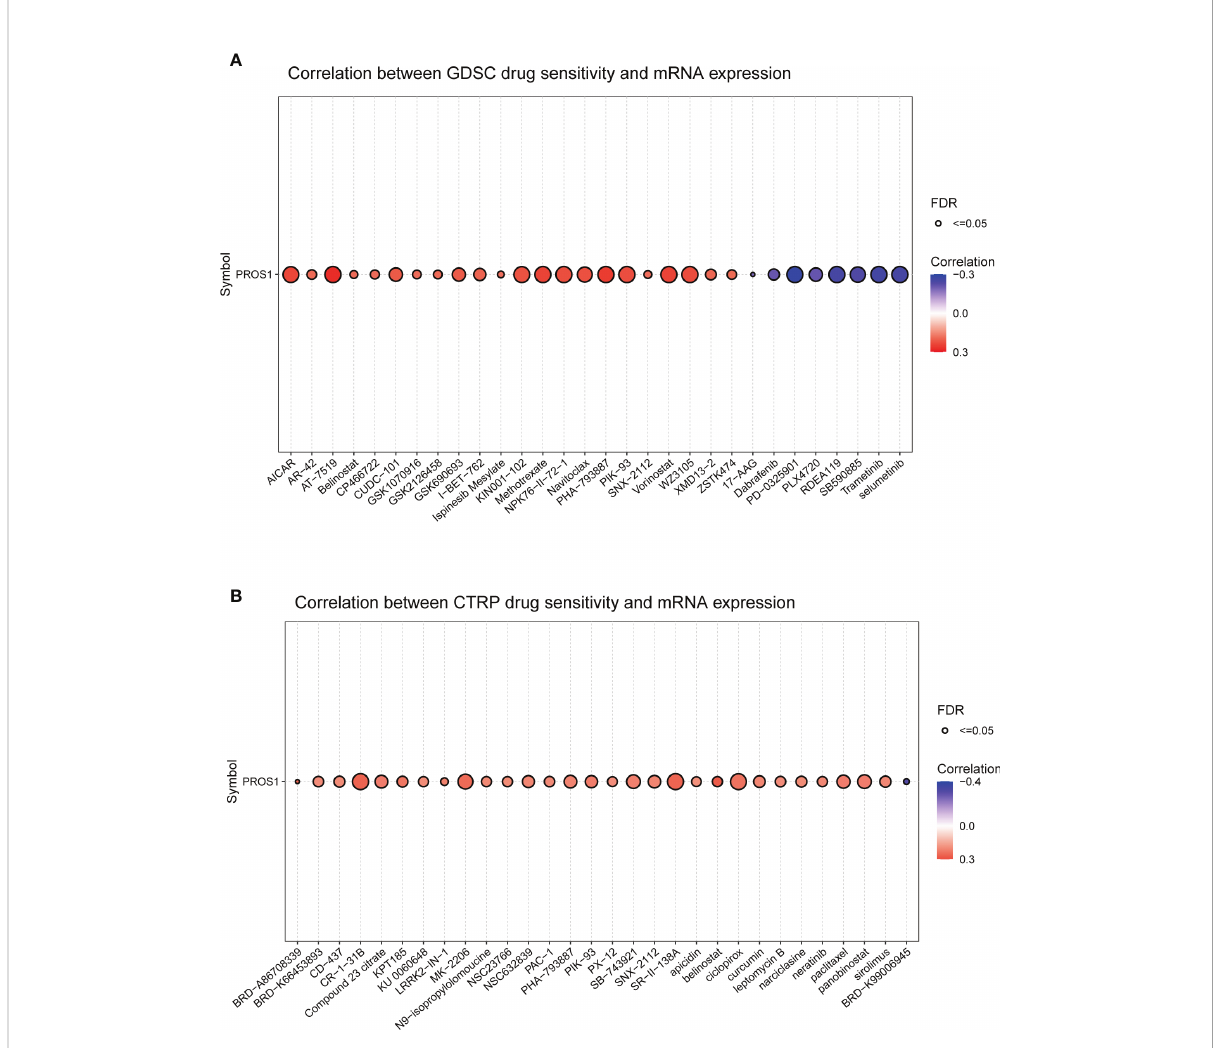
FIGURE 9 Correlation between PROS1 expression and the sensitivity of GDSC drugs and CTRP drugs (top 30) in pan-cancer (A) the correlation between PROS1 expression and the sensitivity of GDSC drugs (top 30) in pan-cancer (B) The association between PROS1 expression and the sensitivity of CTRP drugs (top 30) in